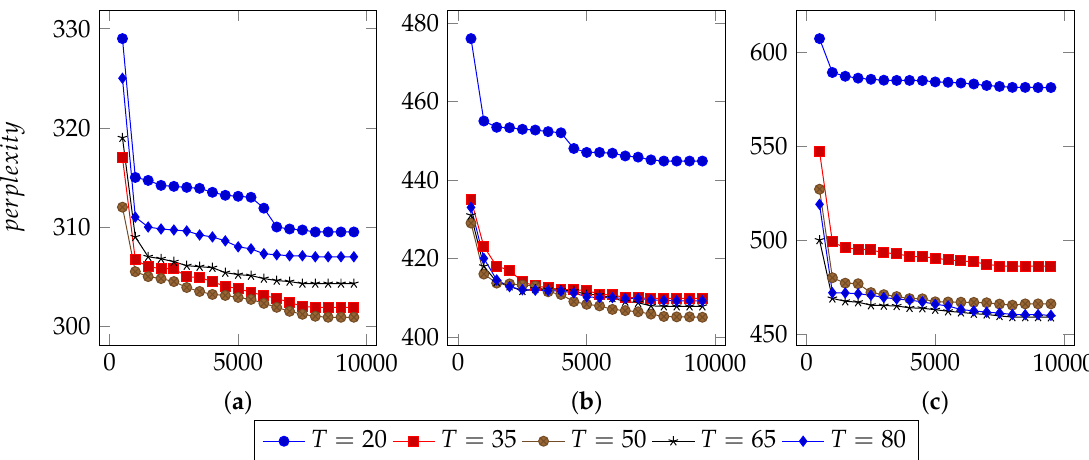
Figure 5. Selection of I for XMPP. ( a ) Perplexity for model with 40% n-grams used; ( b ) Perplexity for model with 60% n-grams used; ( c ) Perplexity for model with 80% n-grams